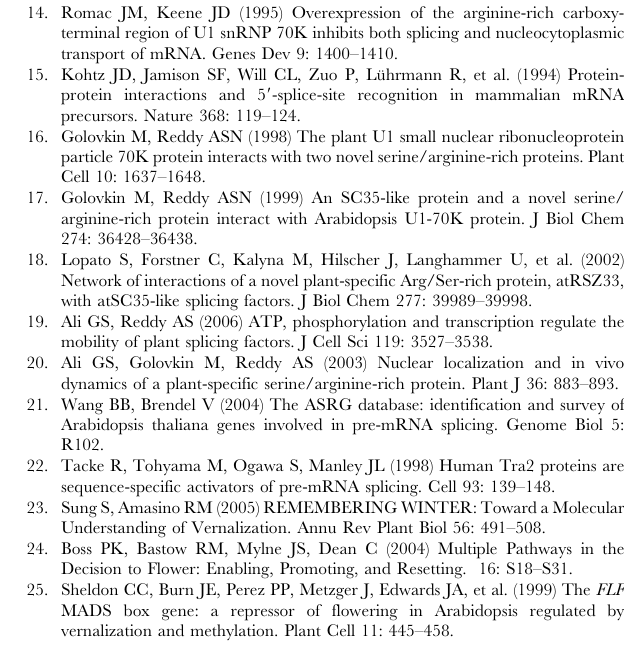
Table S2 Gene expression analyses of all genes present on the Affymetrix Arabidopsis gene chip.